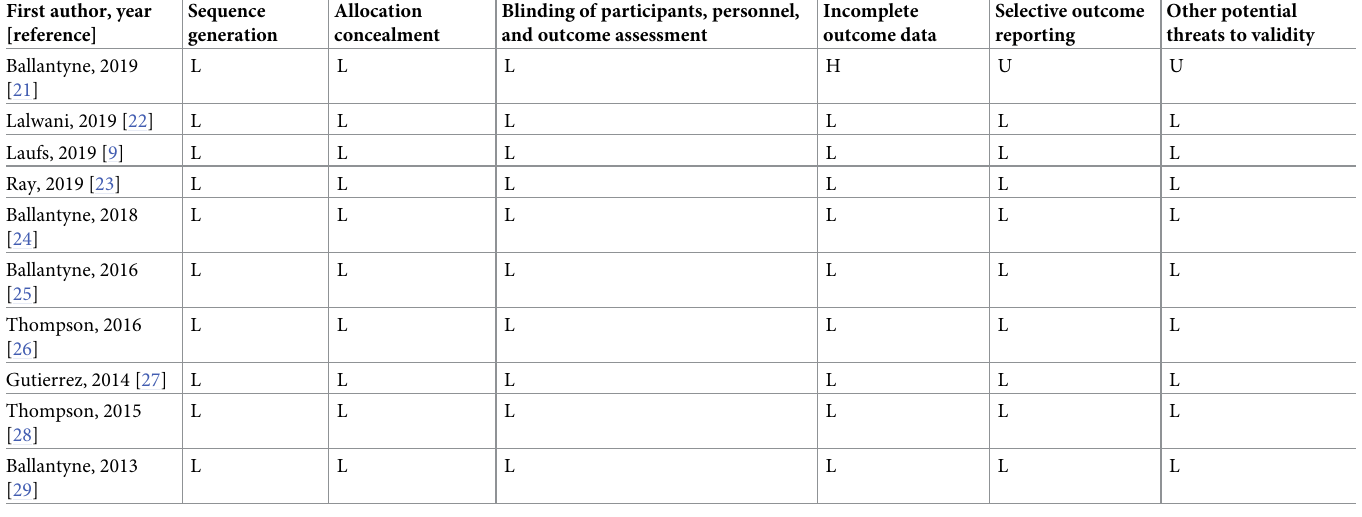
Table 2. Risk of bias evaluation of the studies according to Cochrane